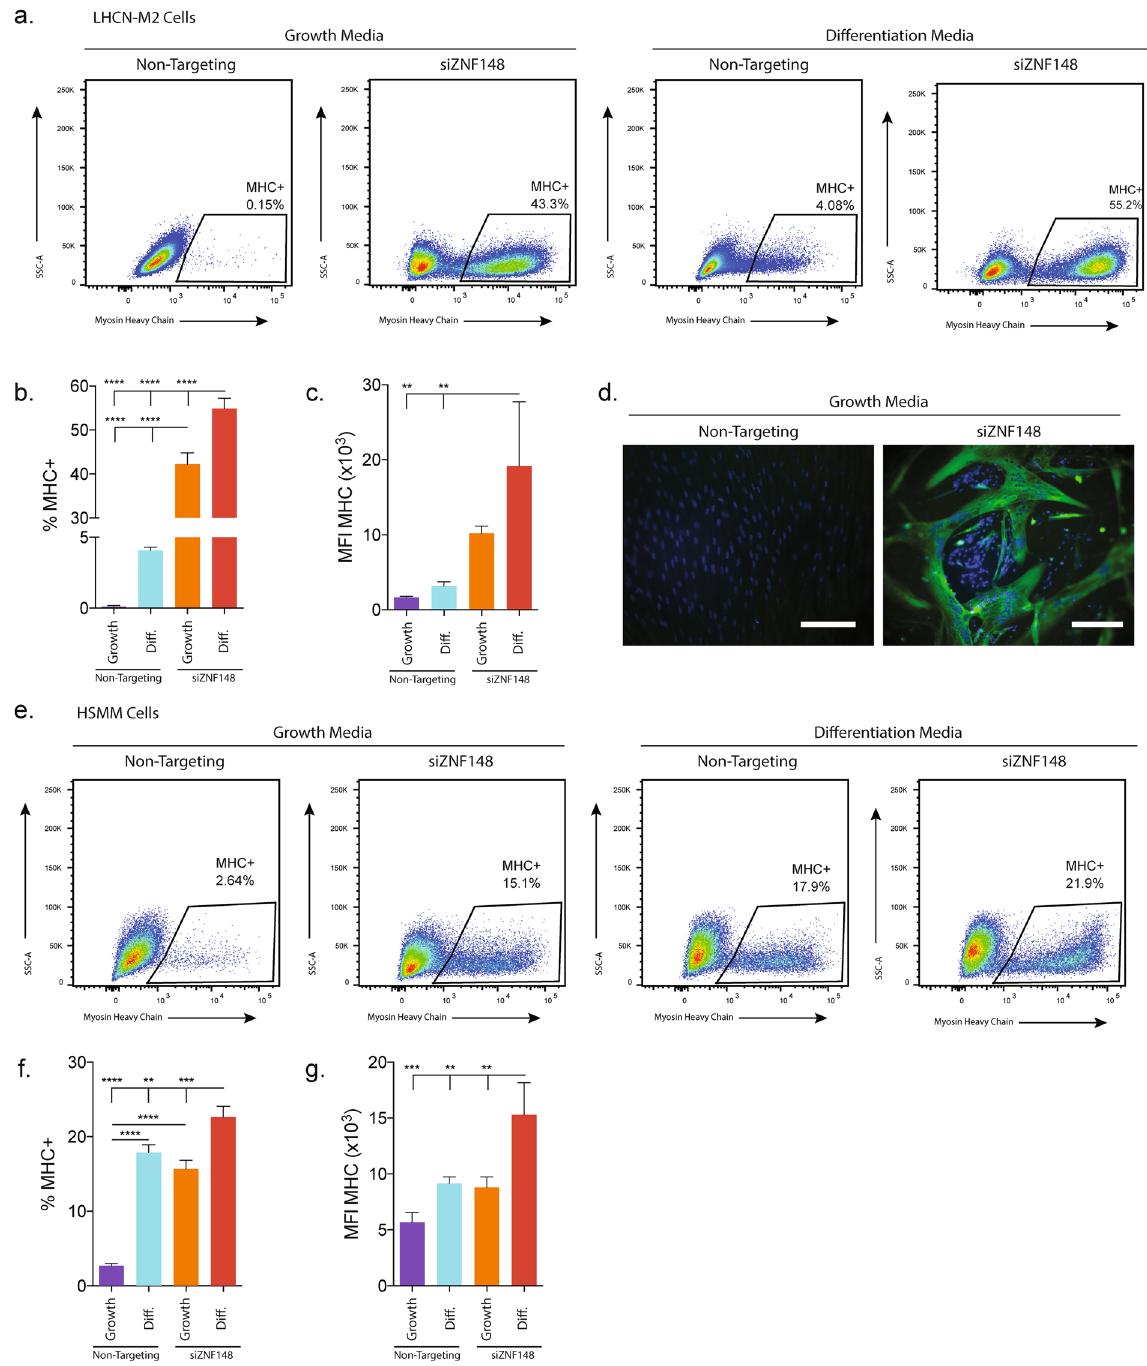
Figure 3. ZNF148 knockdown differentiates cells in proliferative media and is not cell type specific. ( a ) Flow cytometric analysis of myosin heavy chain (MHC) expression in LHCN-M2 cells cultivated for 2 days in growth or differentiation media. ( b ) Quantification of cell population percentages or ( c ) mean fluorescence intensity (MFI) of MHC-high expressing LHCN-M2 cells. Statistical significance was determined by one-way ANOVA. ( d ) Fluorescence microscopy of MHC- (green) and DAPI- (blue) stained LHCN-M2 cells after culture for 3 days in growth media. Scale bar = 50 µ M. ( e ) Flow cytometric analysis of MHC expression in primary human muscle myoblasts (HSMM) cells cultivated for 4 days in growth or differentiation media. ( f ) Quantification of cell population percentage and ( g ) mean fluorescence intensity (MFI) of MHC-high expressing LHCN-M2 cells. Representative figures are shown, n = 3 independent experiments with 250,000 events collected per experiment. Data were analyzed by one-way ANOVA. ** P < 0.01, *** P < 0.001, **** P < 0.0001. SSC-A stands for side scattered light